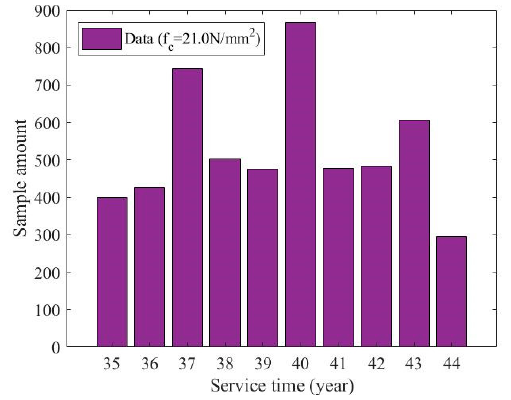
Figure 3. Statistics of concrete strength ( f c = 21.0N/mm 2